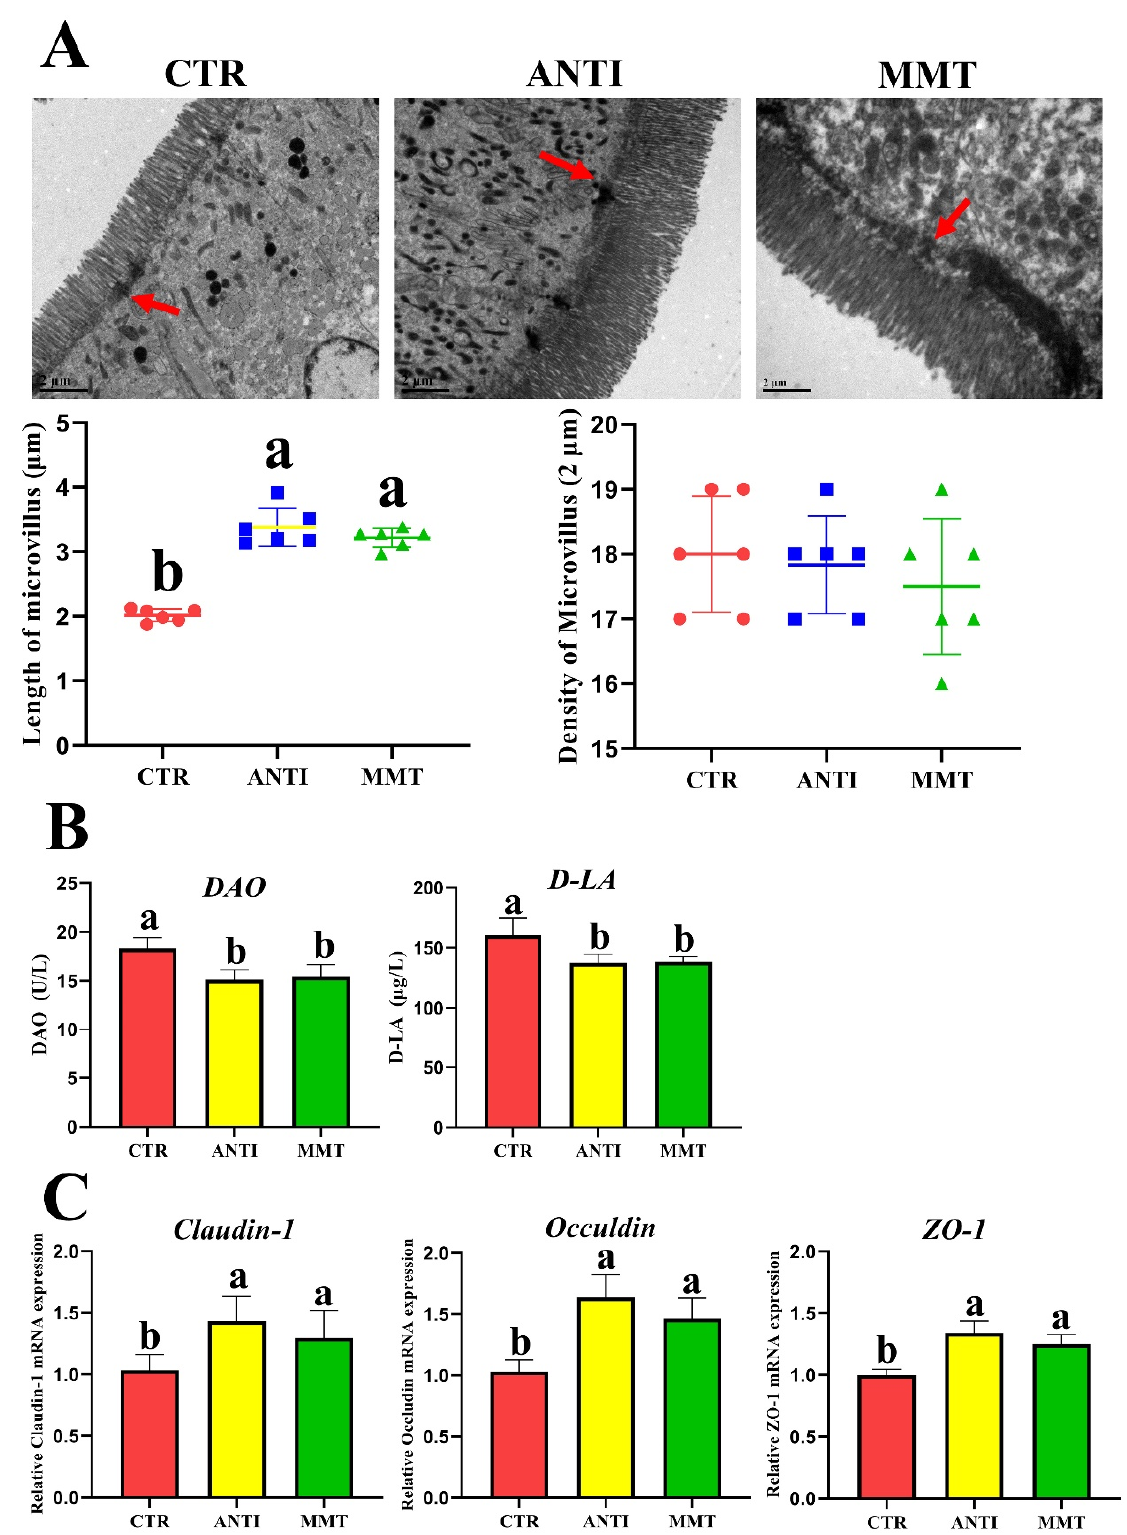
Figure 5. Effects of dietary supplementation with MMT on the intestinal physical barrier function: ( A ) transmission electron micrographs of the jejunum microvilli in broilers, the red arrow indicates desmosomes (DS); ( B ) DAO and D-LA activity in serum; ( C ) the jejunum relative mRNA expressions of claudin-1 , occludin , and ZO-1 were analyzed by real-time qPCR. a,b Data are presented as means ± SD (n = 6). ZO-1, zonula occludens 1.